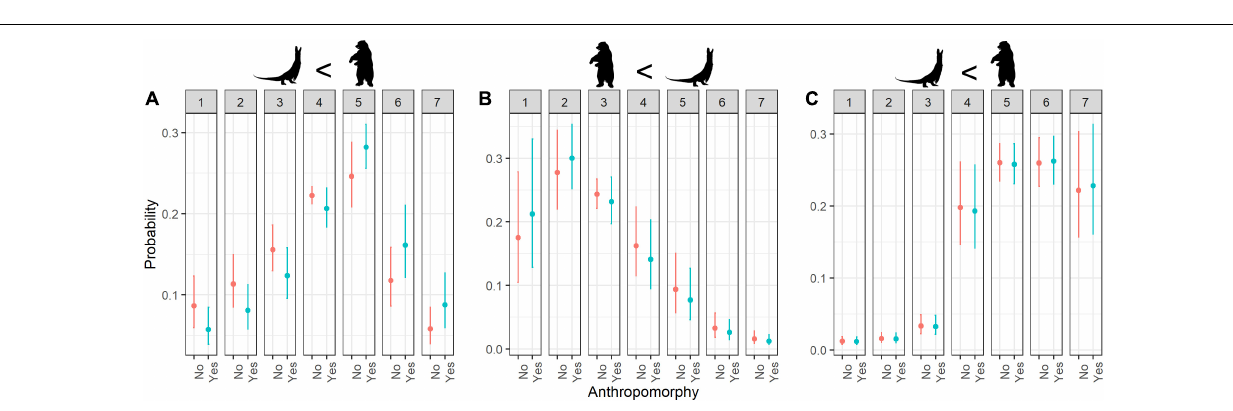
FIGURE 4 | Estimated probability of ratings for (A) cuteness, (B) fear, and (C) willingness to protection according to Anthropomorphy. Error bars indicate 95% confidence interval; numbers 1–7 refer to rating